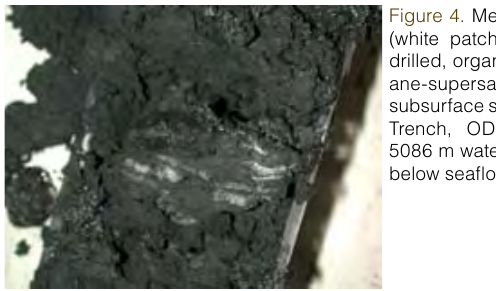
Figure 4. Methane hydrate (white patches) in freshly drilled, organic-rich, meth- ane-supersaturated deep subsurface sediment (Peru Trench, ODP Site 1230, 5086 m water depth, 96 m below